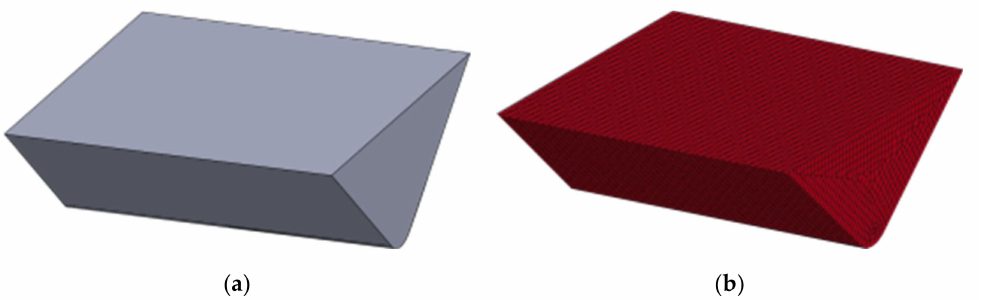
Figure 6. Center of gravity of human head model.